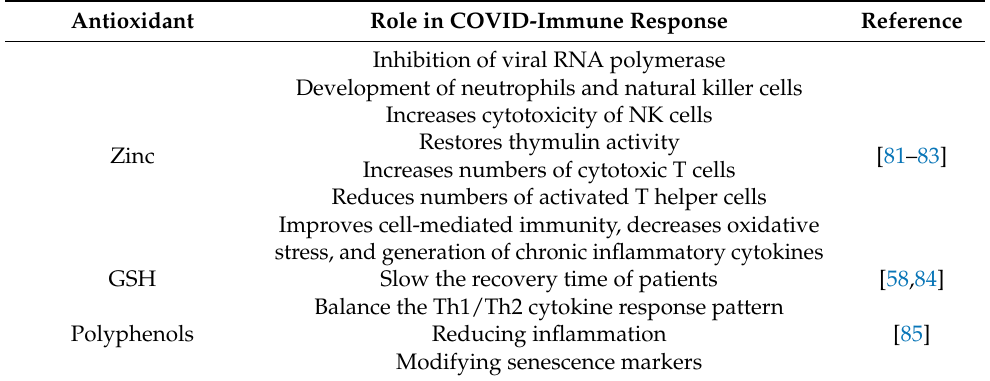
Table 1. Impact of the antioxidants zinc, glutathione and polyphenols in the COVID-19 immune